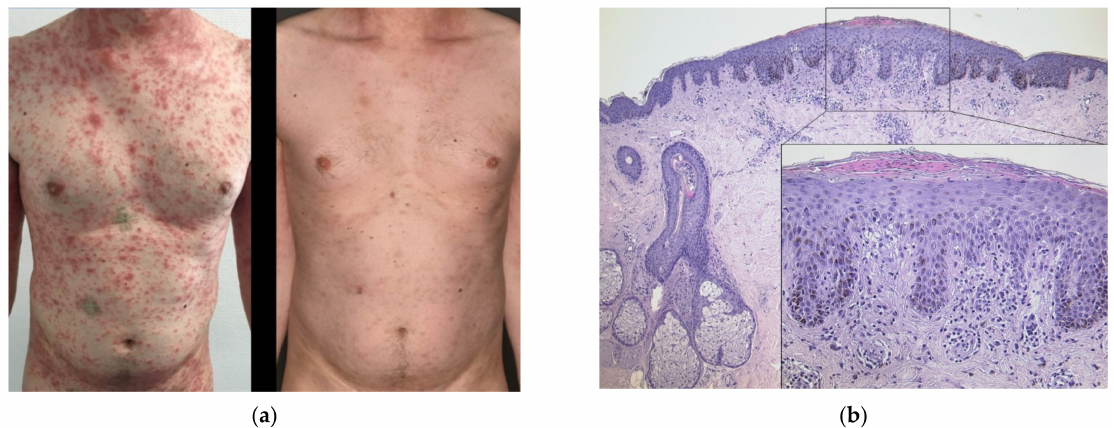
Figure 3. ( a ) Clinical findings five weeks after the first dose of mRNA-based COVID-19 vaccine featuring scaling papules and plaques which had already been present for two weeks (left), and clinical presentation eleven days later with intensified dermatological treatment (right). ( b ) Histological findings of a nevus which was excised to rule out malignancy displaying marked parakeratosis, irregular rete acanthosis and spongiosis, consistent with a psoriasiform eczematous drug reaction (HE, original magnification 50 × , detail original magnification 200 × ). These histological findings were congruent with two other skin biopsies from the trunk.